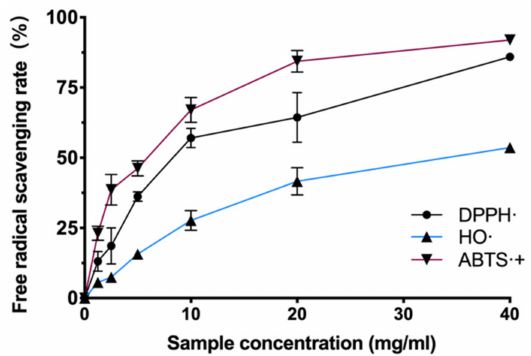
Figure 1. Antioxidant ability of